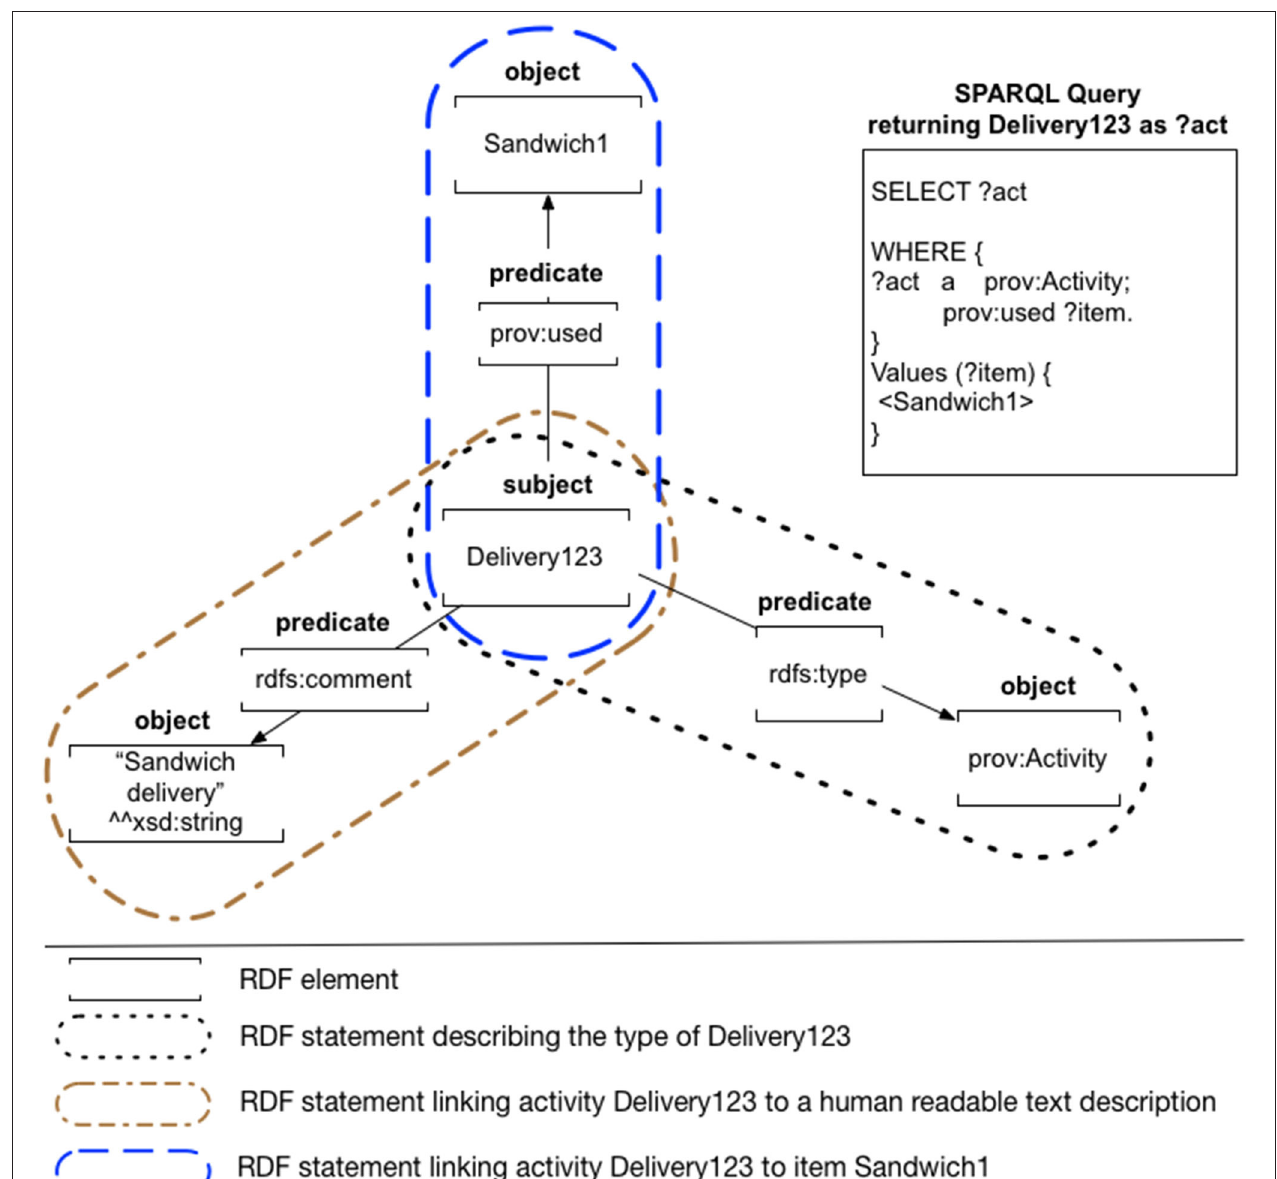
FIGURE 1 | An overview of semantic technologies for representing and querying graph